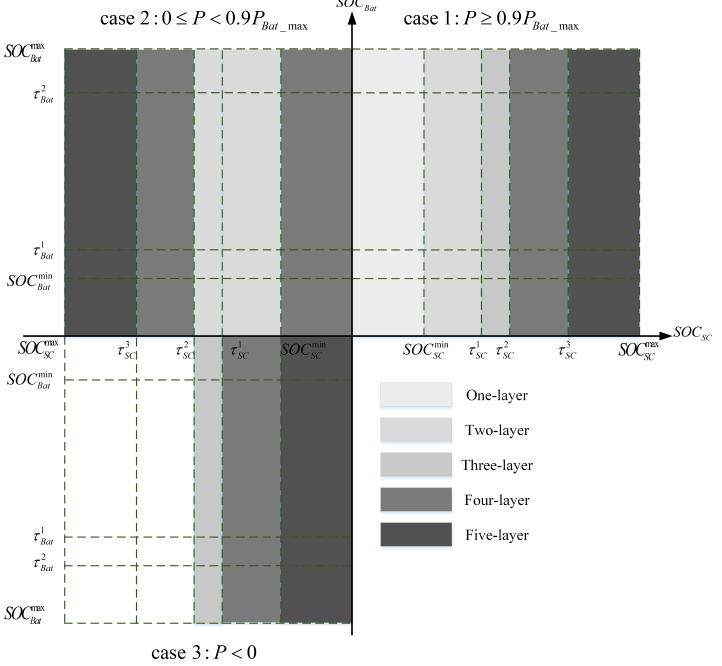
Figure 7. The correspondence between the number of decomposition layers of wavelet transform L W and the operation zone L SC of